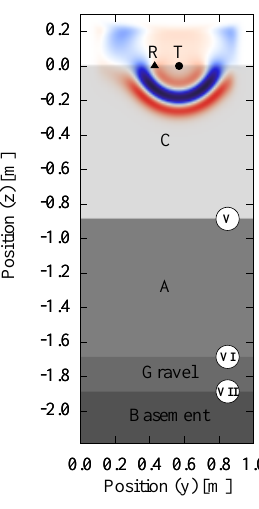
Figure 7. For the simulation of the GPR signal, we assume a layered subsurface architecture (Fig. 1). The transmitter of the antenna is represented with an infinitesimal dipole (T) and the electric field is read at the position of the receiver antenna (R). A perfectly matched layer is used as boundary condition. The x component of the result- ing electric field after 5ns is shown. The markers for the material interfaces are used consistently in this work. The position of the in- terface of materials C and A (V) as well the position of the interface of materials A and gravel (VI) are parameterized ( d V and d VI ) and can be